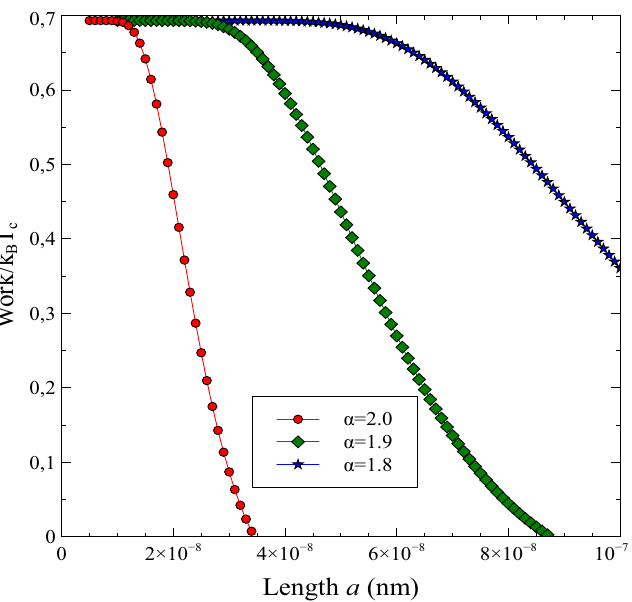
Figure 3. Work W of the space-fractional quantum heat engine versus length a (in nano-meters) for the various fractional exponents. Here, we have set the constants as m